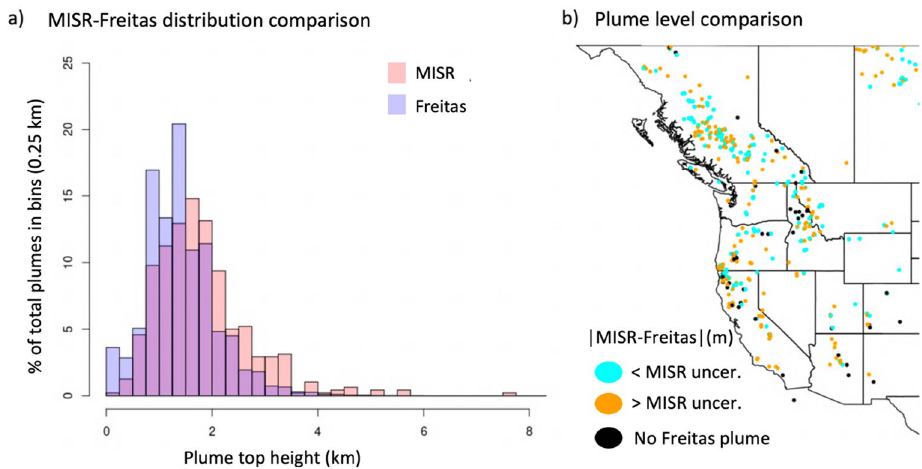
Figure 5. ( a ) A comparison of the distribution of MISR-observed and Freitas-modeled wildfire plume top heights occurring over the Western US and Canada during the months of August and September. ( b ) A map depicting the locations of the MISR-observed plumes used for validation, with color coding used to indicate whether a collocated plume from the modeled climatology agrees within the range of MISR uncertainty. These plumes represent the years 2008–2011 and 2017–2018, reflecting the limited temporal coverage of the MISR plume tops dataset.